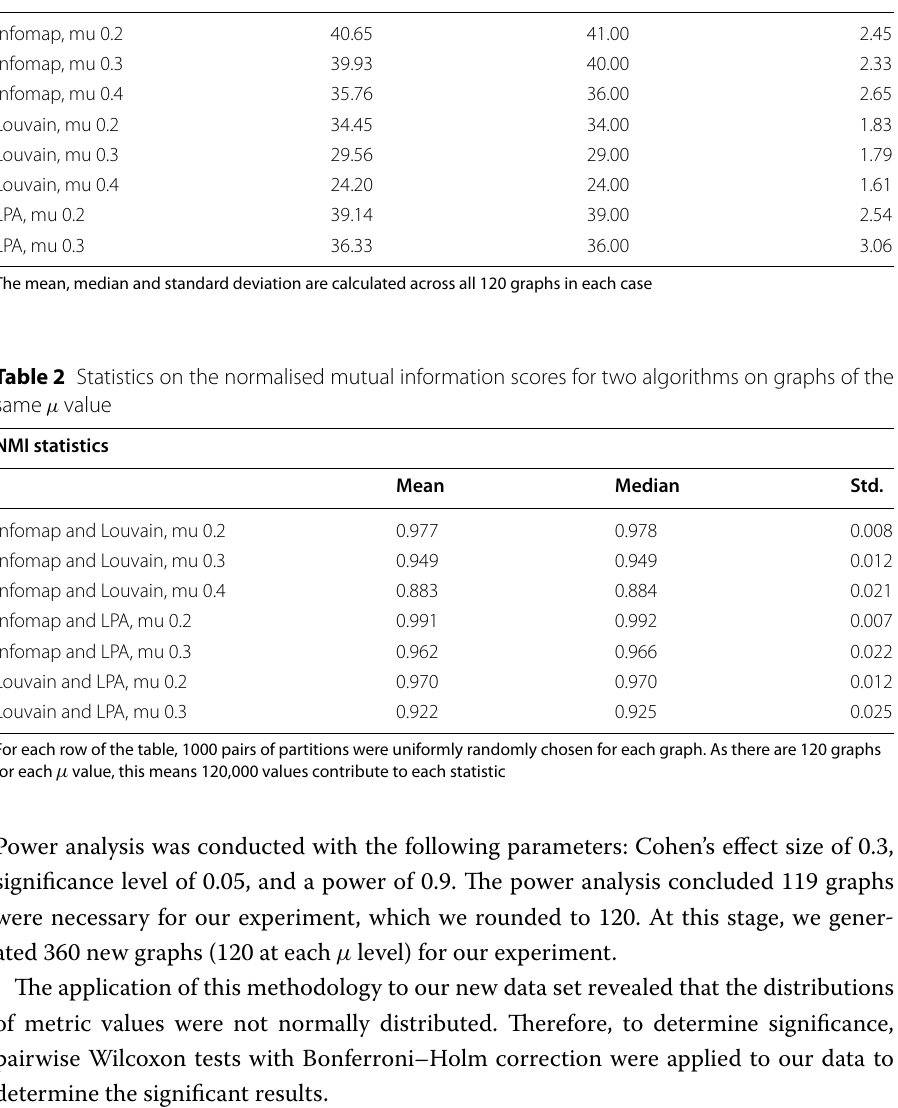
Table 1 The numbers of communities identified by each algorithm on graphs with 1000 nodes Number of communities Mean